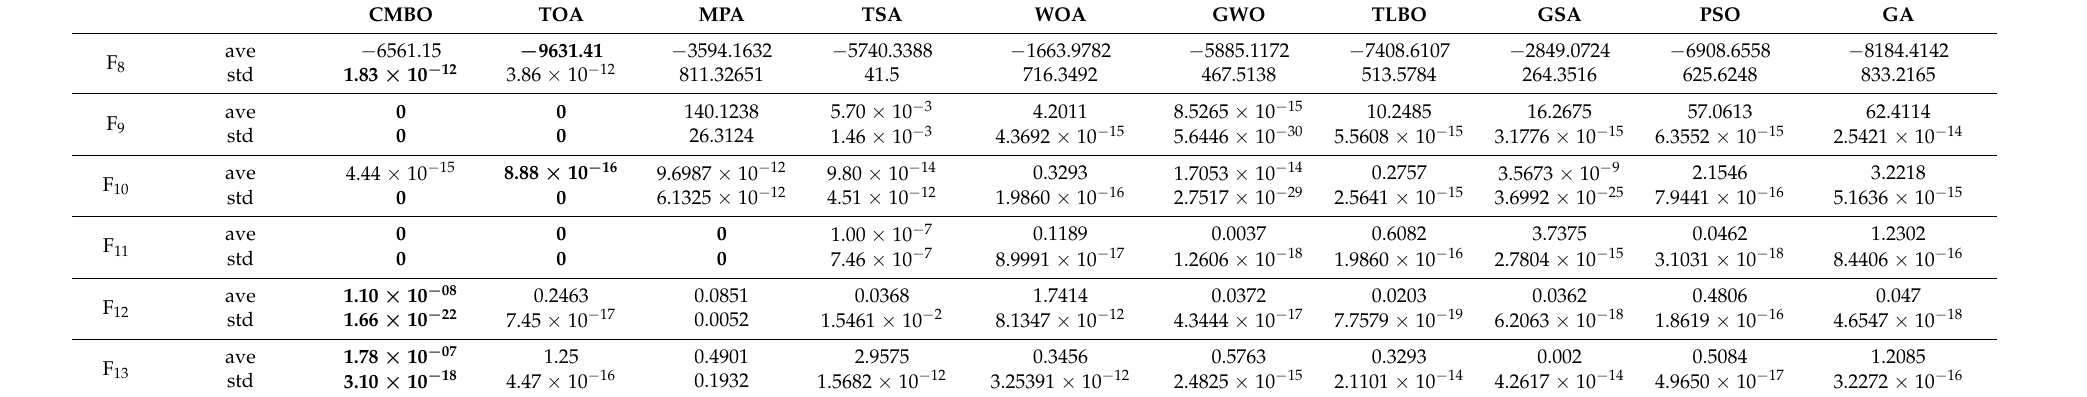
Table 5. Optimization results of CMBO and other algorithms on high-dimensional